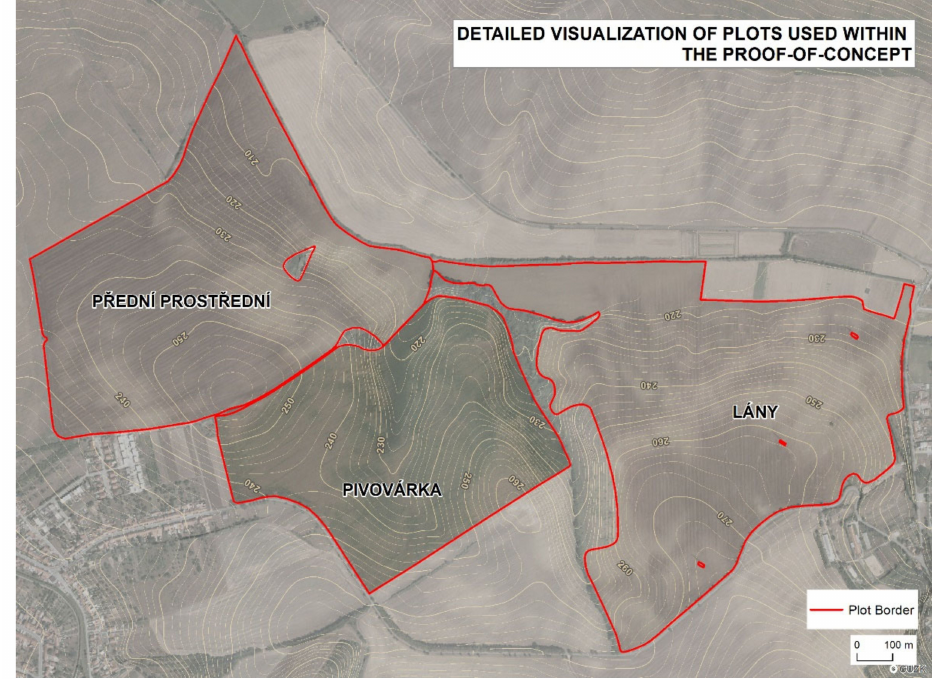
Figure 3. Detailed visualization of plots used within the